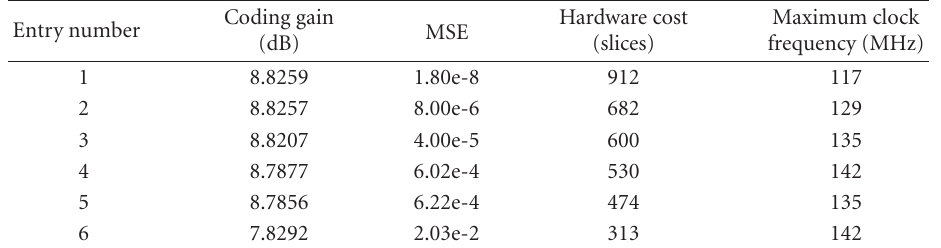
Table 1: Coding gain, MSE, hardware cost, and maximum clock frequency results for DCT approximations based on Loe ffl er’s factorization using the lifting structure implemented on the XCV300-6 FPGA.